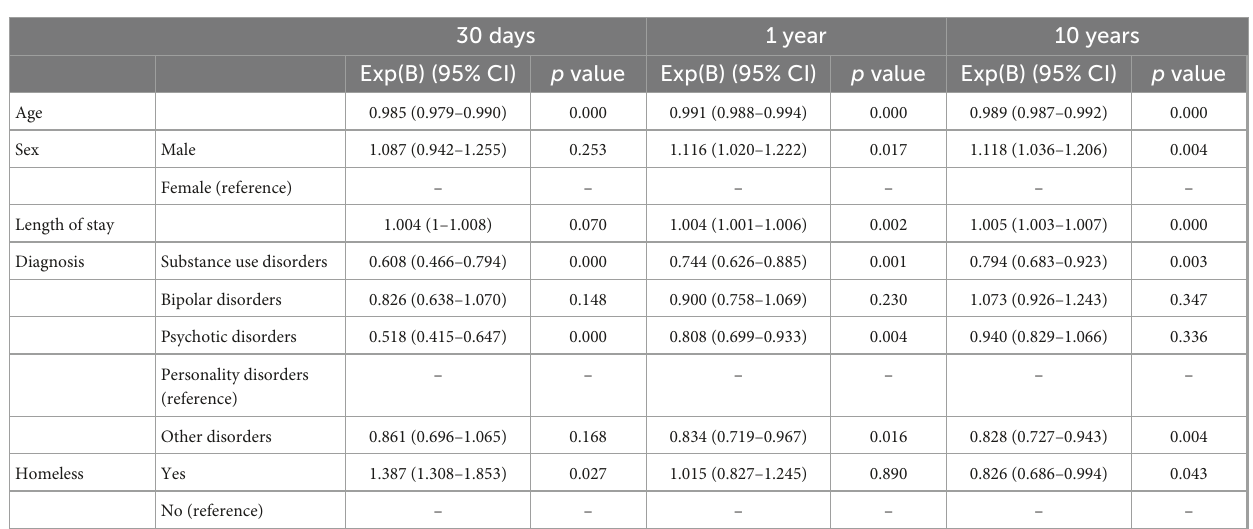
TABLE 3 Multivariate cox regression